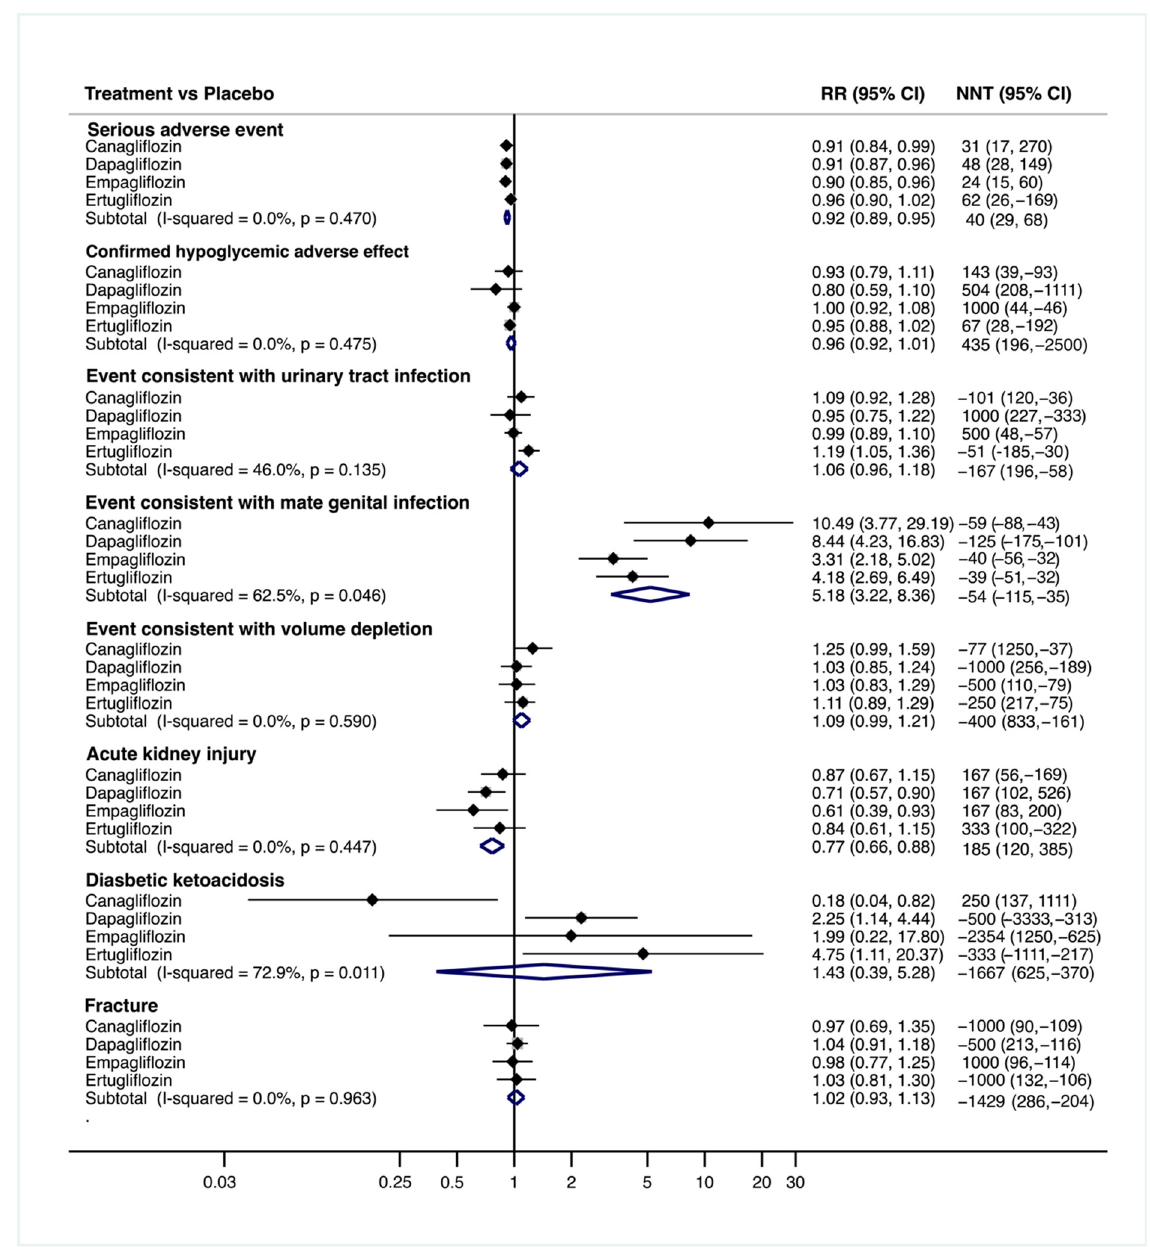
Figure 4. Forest plot for canagliflozin, dapagliflozin, empagliflozin and ertugliflozin vs. placebo to assess adverse effects. Abbreviations: CI: confidence interval; RR: relative risk; NNT: number needed to treat (calculated as 1/Absolute risk reduction (ARR), with ARR = exposed incidence minus non-exposed incidence). The RR and its 95% CI and the corresponding NNT and its 95% CI for each comparison are shown. The RR effect measure has been estimated from a number of events from original studies and has been transformed to NNT. Positive values of NNT means the number needed to observe a benefit and negative values means the number needed to observe